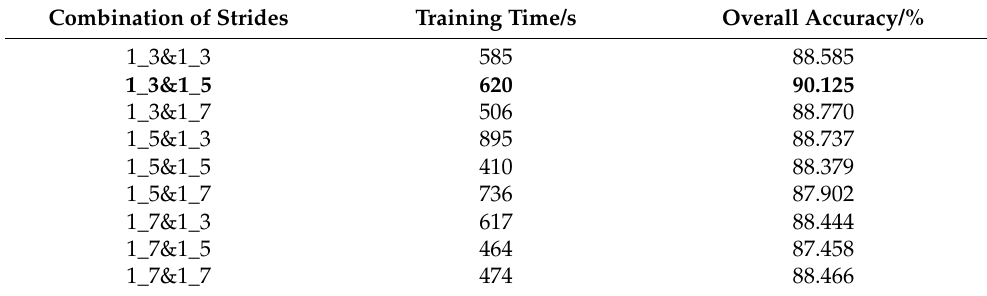
Table 3. Accuracy and training time for different stride combinations on the Indian Pines dataset.